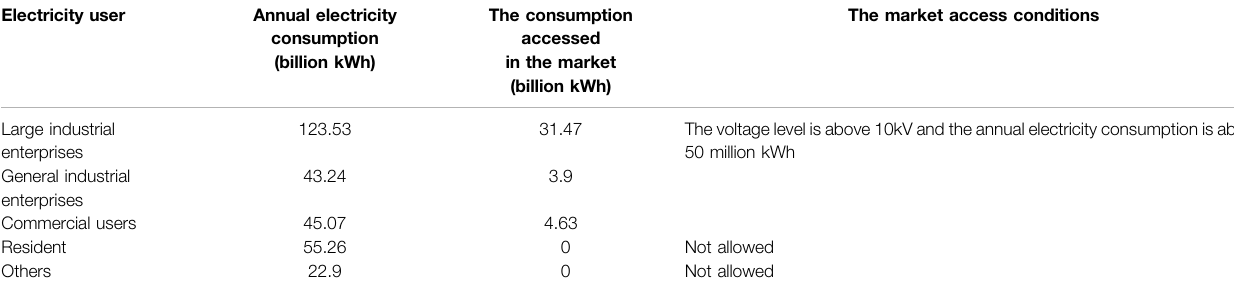
TABLE 2 | The annual electricity consumption and market electricity of various